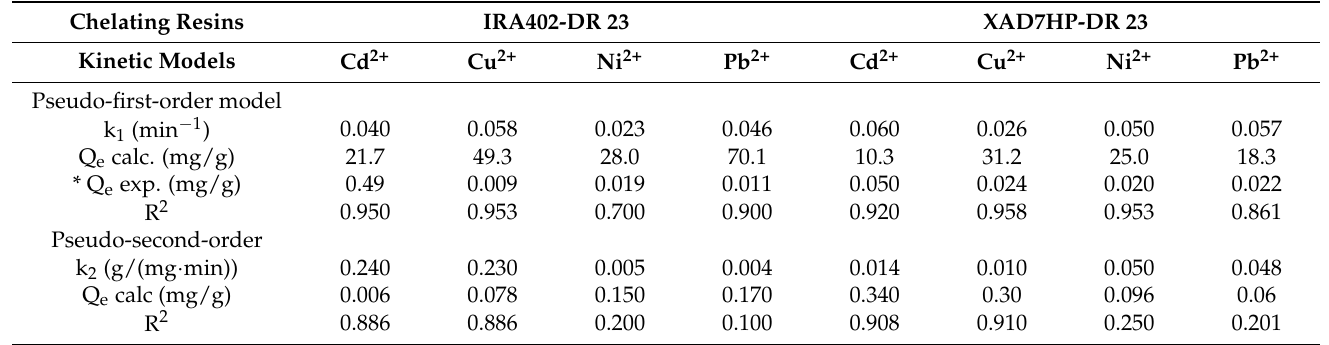
Table 1. Kinetic constants of M 2+ adsorption on the IRA 402-DR 23 and XAD7HP-DR